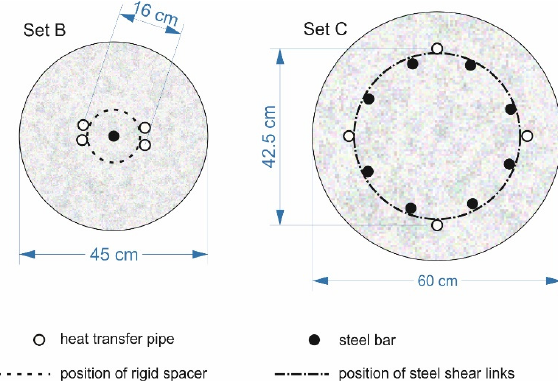
Figure 3. Sketch of the piles used in the analysis: set B ( left ) and set C ( right ).